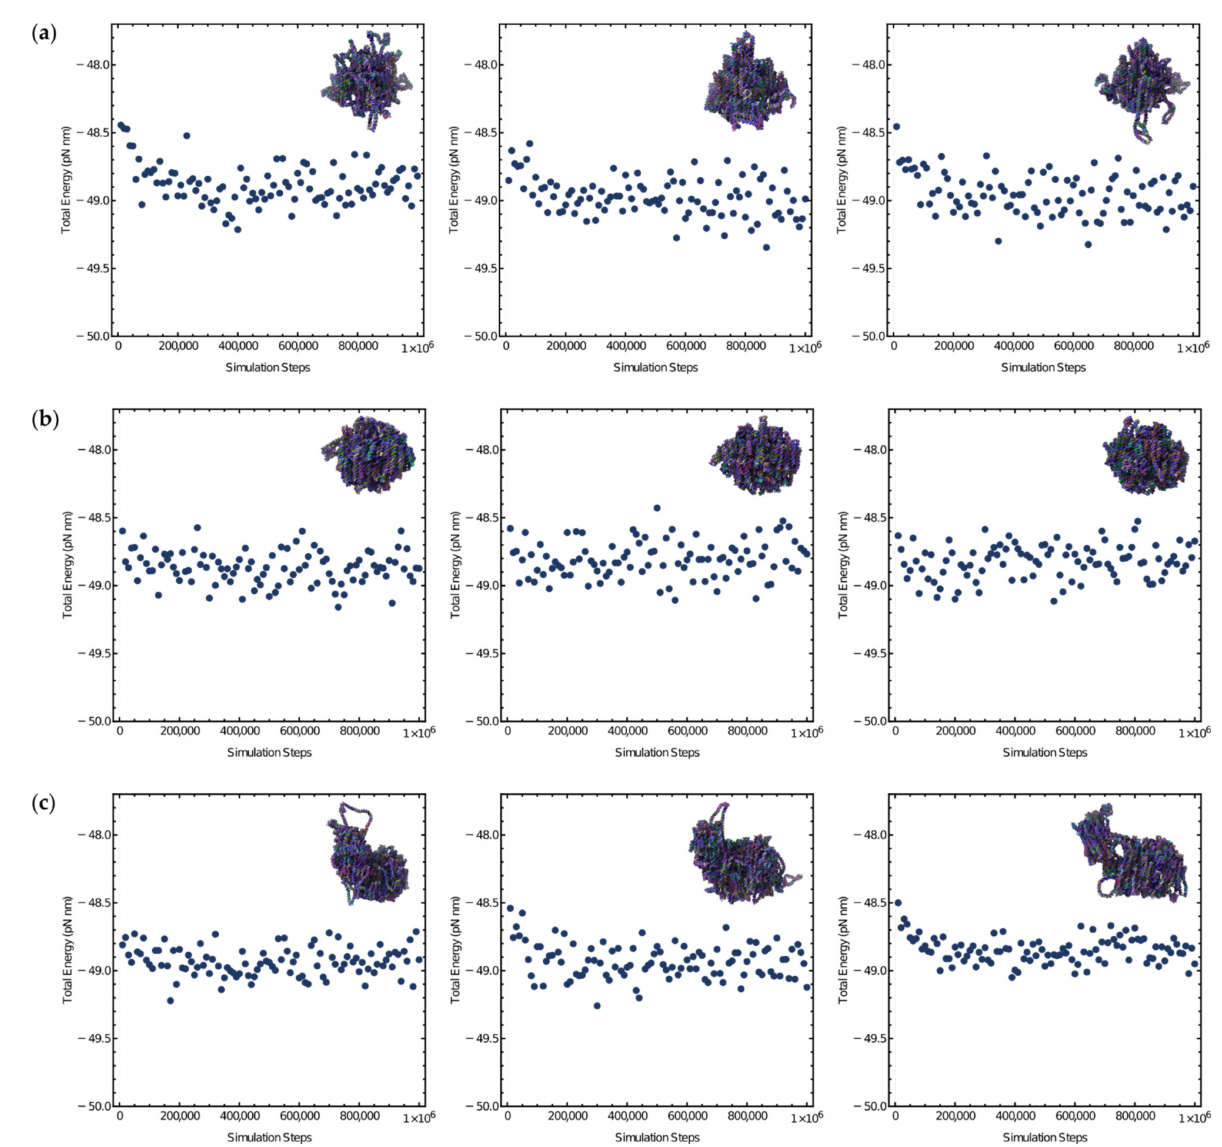
Figure 9. Total system energy measurements (converted to pN nm from simulation units) over the course of the oxDNA relaxation step, corresponding to the structures in Figures 7 and 8: ( a ) Plots for structures with the tetrahedron mesh as the outer bounds of the design space; ( b ) Plots for structures with the snub cube mesh as the outer bounds of the design space; ( c ) Plots for structures with the Stanford bunny mesh as the outer bounds of the design space. The plateauing of the total energy of the systems as it progresses through the relaxation simulation is an indication that equilibrium has been achieved. More anisotropic shapes with narrow features took longer to reach